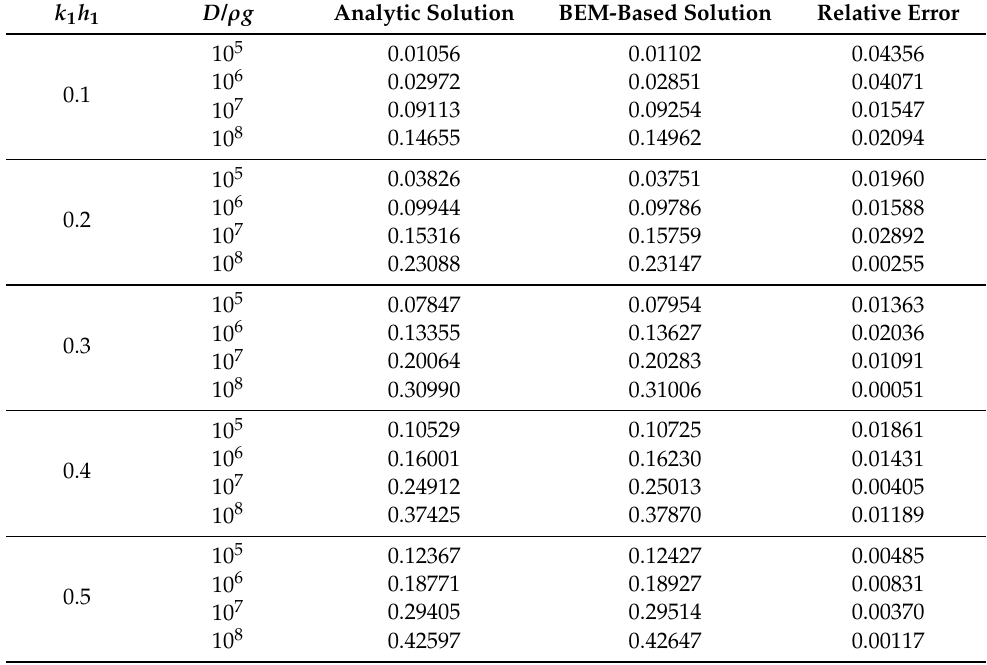
Table 2. Relative error corresponding to Figure